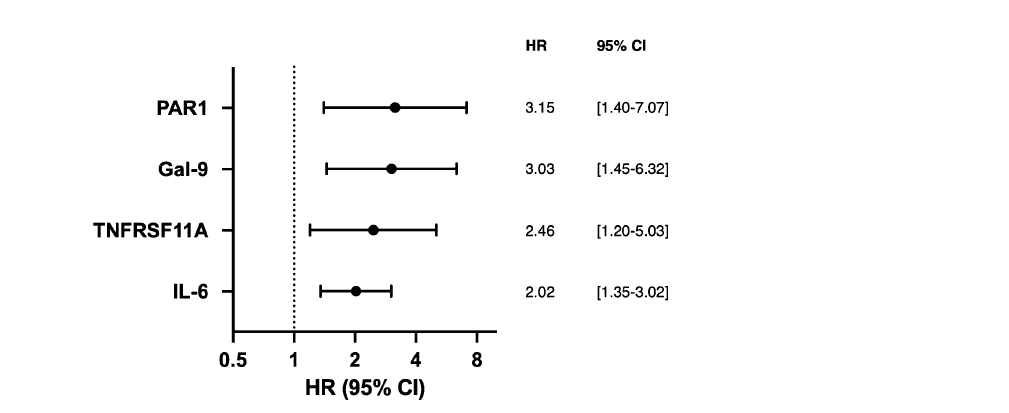
Figure 2. Biomarkers with significantly increased plasma levels in patients with events, identified by multivariate cox regression analysis with